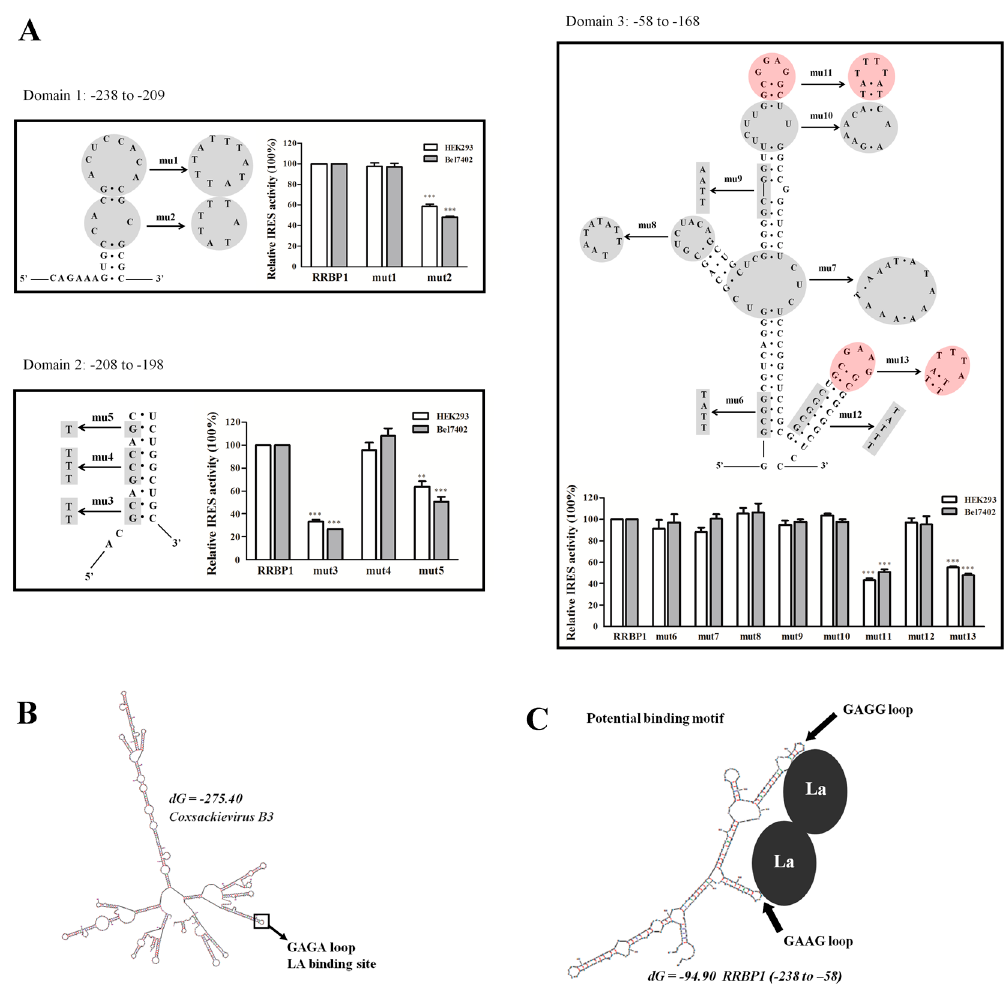
Figure 6. Mutational analysis of RRBP1 5 ′ UTR. ( A ) Thirteen mutations (with grey or red marker) which were made within the domains 1–3 of RRBP1 5 ′ UTR were inserted into the vector pRF, respectively. HEK293 and Bel7402 cells were transfected with either wild-type or the mutated versions of RRBP1 5 ′ UTR. The IRES activity from each cell line was determined and normalized to wild-type IRES (RRBP1, set to 100%). The expression data are presented as the mean ± SEM of triplicate samples (**: p < 0.005; ***: p < 0.0005); ( B ) the predicted secondary structure of coxsackievirus B3 (CVB3) 5 ′ UTR was generated by Mfold software indicating the position of the apical GAGA loop; and ( C ) the predicted secondary structure of RRBP1 IRES (-238 to -58) indicating the potential LA binding position of two apical GARR loops.